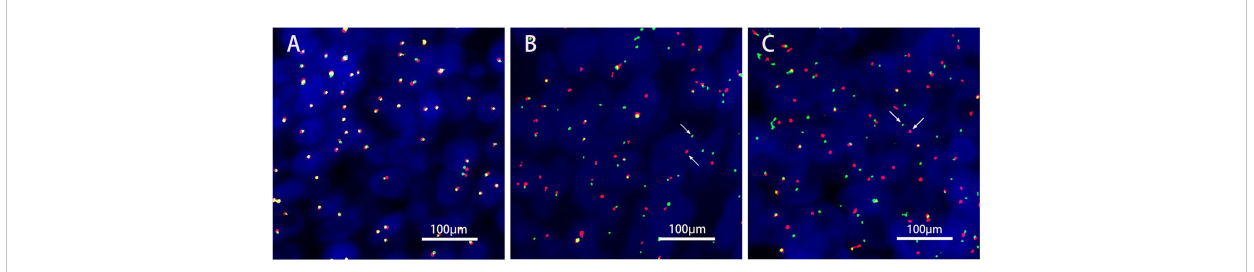
FIGURE 2 NUT gene rearrangement detection(FISH- Right parotid gland tissue). The green signal(G) was GSP NUT(Telomere); The red signal ® was GSP NUT (Centromere). (A) Negative control. (B) Positive control. (C) . FISH NUT (+) (red and green signal separation was seen in tumor cells, indicating that the gene was disrupted, Each signal mode is as follows: 1G1R1F 64.0%,IG1F 8.0%,1R1F 5.0%,1GIR 10.0%,2G1R 3.0%,IF 5.0%,2F